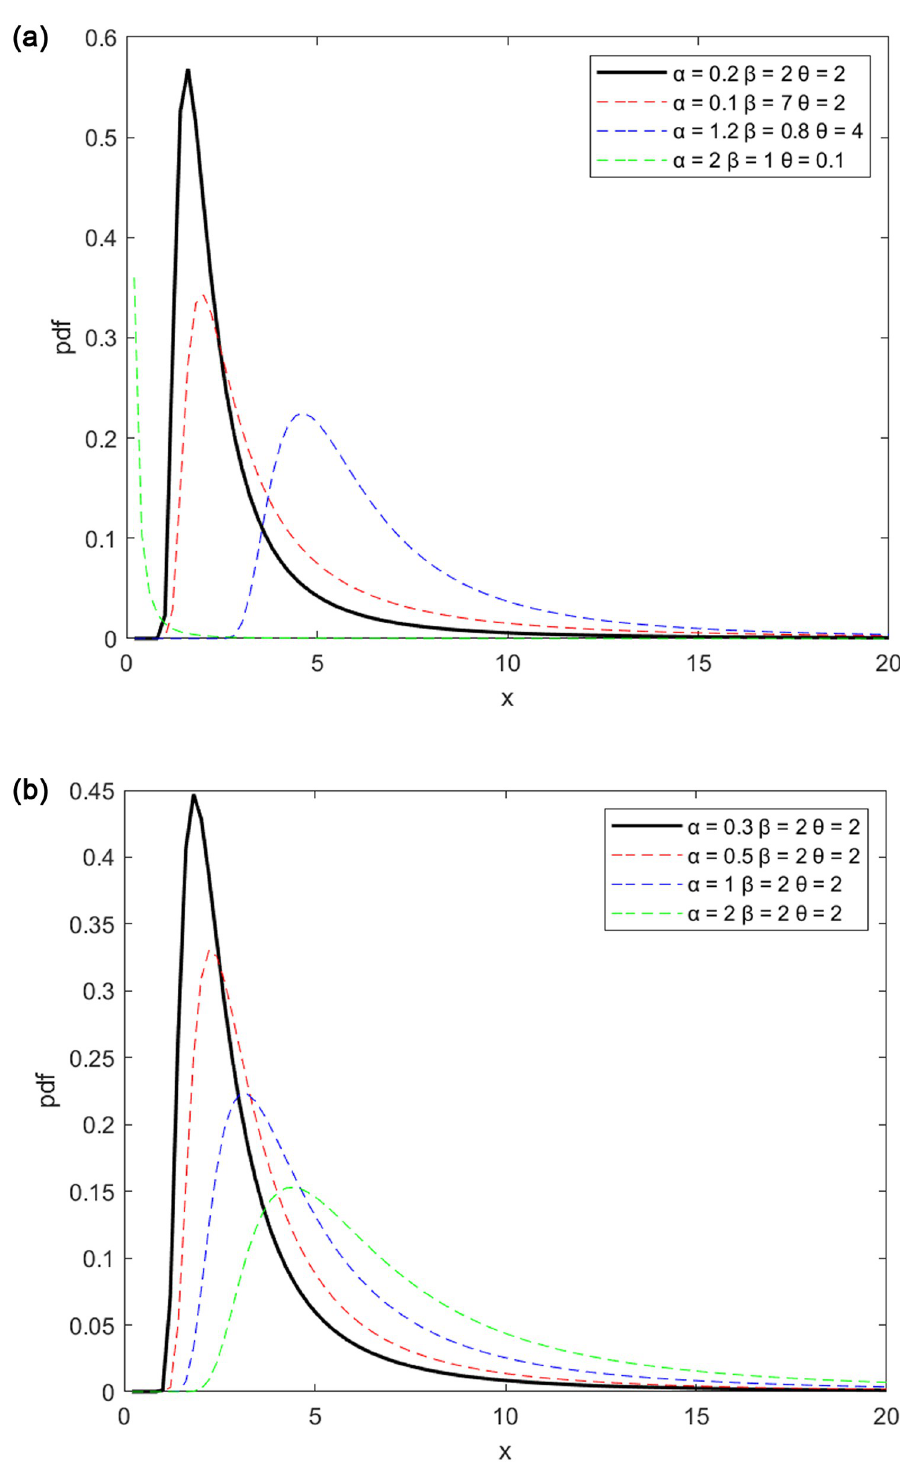
Fig 1. Probability density functions of the new MPTLILx. (a) For different parameter sets. (b) For different values of α and β = 2 and θ =